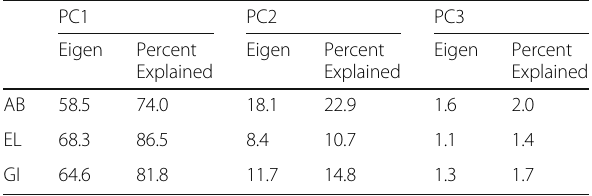
Table 7 Eigenvalues and explanation percentages of three components of PCA on three different